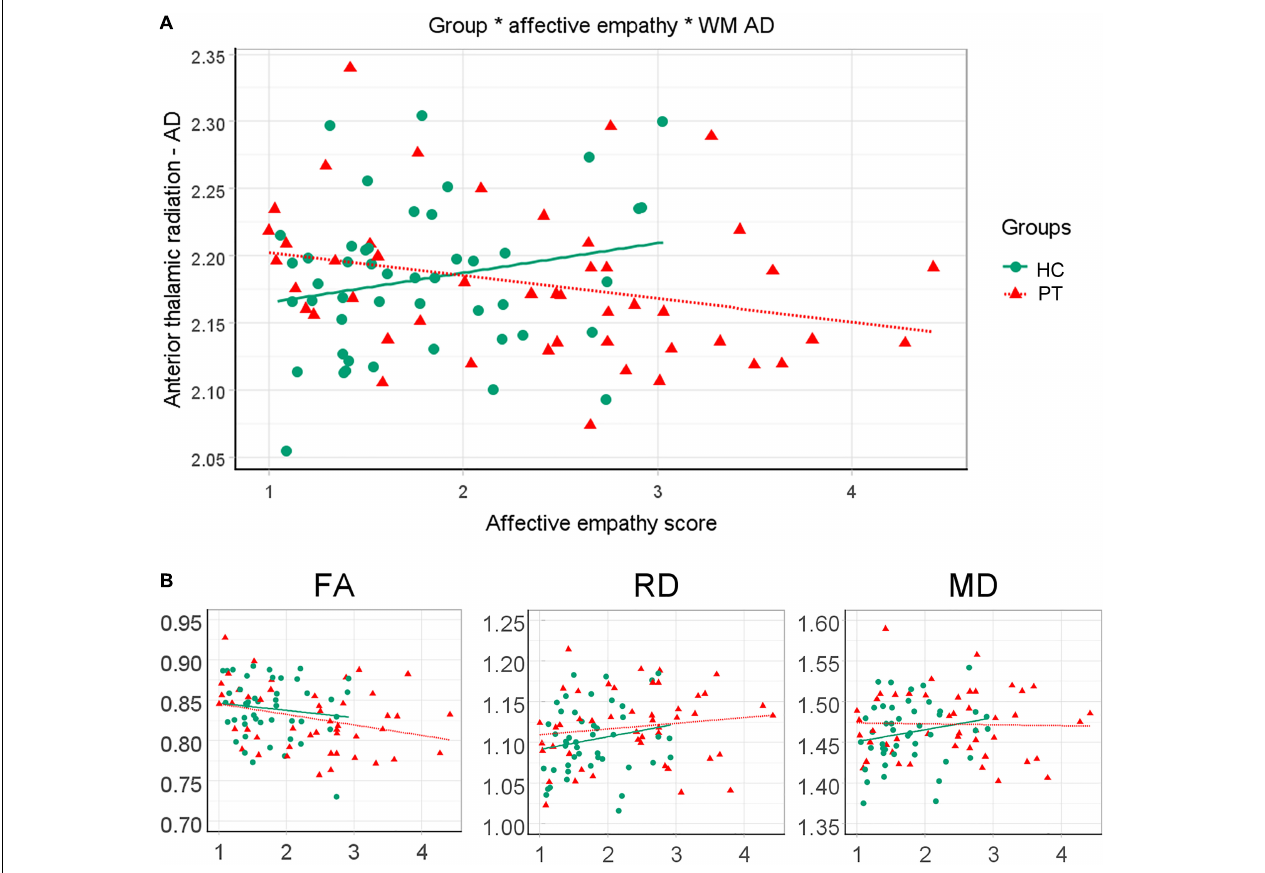
FIGURE 4 | Differential relation between affective empathy and white matter diffusivity measures between patients and controls. (A) Anterior thalamic radiation AD*1000 is plotted against mean affective empathy in healthy controls (green circles/solid line) and patients (red triangles/small-dashed line). Dots are raw values lines are linear fitted trend lines. (B) Similar plots but for FA, RD*1000 and MD*1000 in the anterior thalamic